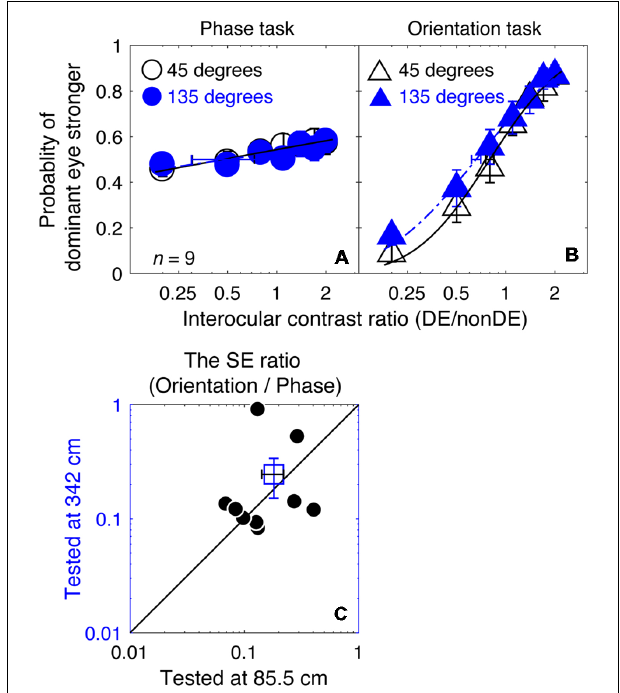
FIGURE 6 | A comparison of the precision of the two tasks at 8 cycles/degree; viewing distance of 85.5 cm vs. 342 cm. The average psychometric functions for the two tasks and two viewing distances are plotted in (A,B) : black circles and black triangles represent the mean probability of DE stronger for the binocular phase combination paradigm and the binocular orientation combination paradigm when the viewing distance was 85.5 cm (i.e., a low stimuli resolution; data from Experiment 1); blue circles and red triangles represent the mean probability of DE stronger for the binocular phase combination paradigm and the binocular orientation combination paradigm when the viewing distance was 342 cm (i.e., stimuli resolution increased to four times higher; data from Experiment 3). The solid and dash line represents the best fitting cumulative distribution functions. Error bars represent SEs across the nine subjects. (C) The sigma ratio between the orientation task and the phase task at the 342 cm conditions was plotted as a function of that at the 85.5 cm condition for the nine observers. Each open circle represents results of one observer; the filled circle represents the averaged results. The dash line is the equal line. Error bars represent SEs across the nine